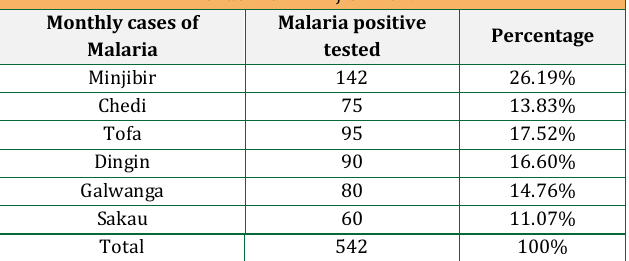
Table 2: Average Monthly analysis of the prevalence of the